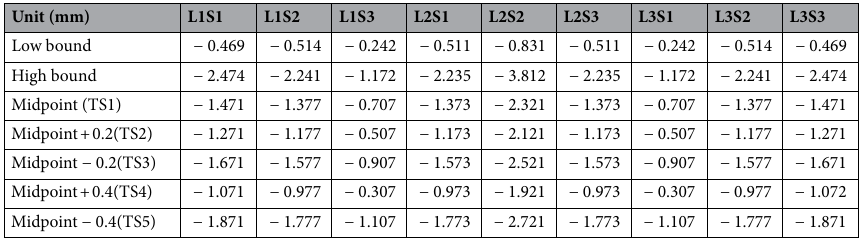
Table 4. The target deflection sets for 20 voxel single void structured beam.